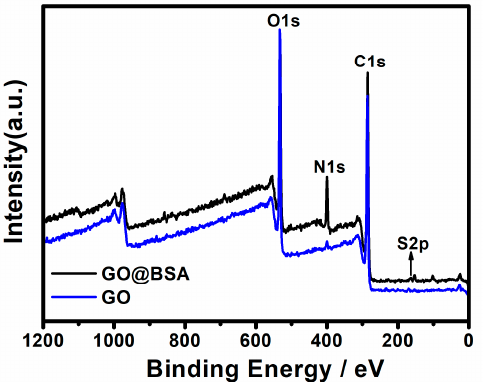
Table 1. Summary table composition of each substance.